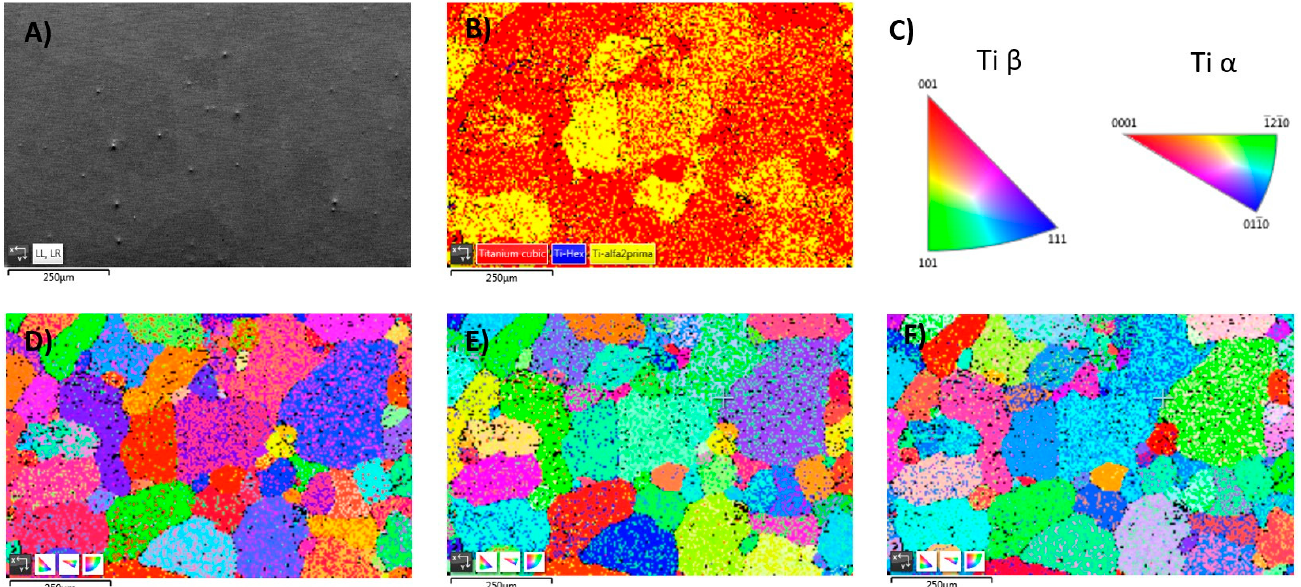
Figure 3. The microstructure of Ti35Nb2Sn after HIPping under 1200 °C, 150 MPa, and cooling rate 100 °C/min (HIP 2). ( A ) SEM image. ( B ) images showing the α ” precipitates. ( C ) crystallographic orientation for β and α phase. ( D – F ) Inverse pole figures (IPF) for X, Y, and Z reference direction maps highlighting grains.